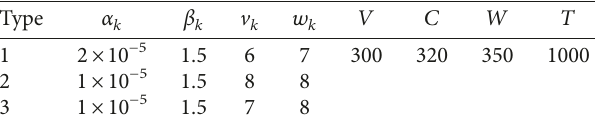
Table 11: Parameters used in optimization (Example